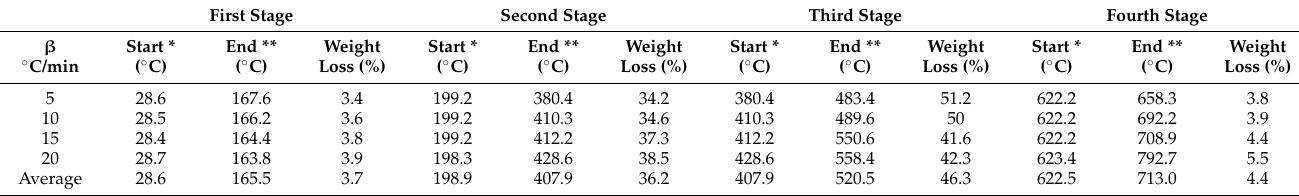
Table 3. Thermal decomposition of Subcoal™ PAF in CO 2 from TGA